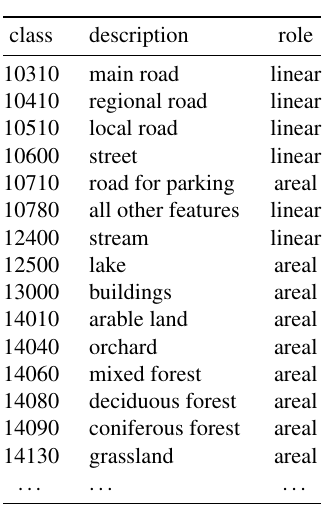
Figure 1. The conceptual model of the SDF.